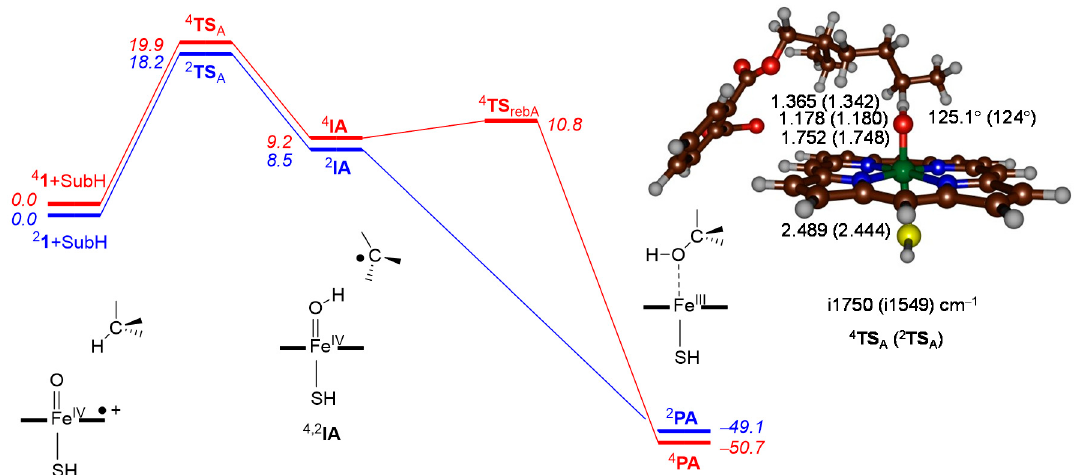
Figure 5. Potential energy landscape (B3LYP/BS1 optimized) of phthalate hydroxylation by P450 CpdI at the C 5 position. Relative energies contain zero-point corrections and are taken from B3LYP/BS2//B3LYP/BS1 in kcal·mol − 1 . Optimized geometries give bond lengths in angstroms, the Fe–O–C angle in degrees and the imaginary frequency in the transition state in cm − 1 .